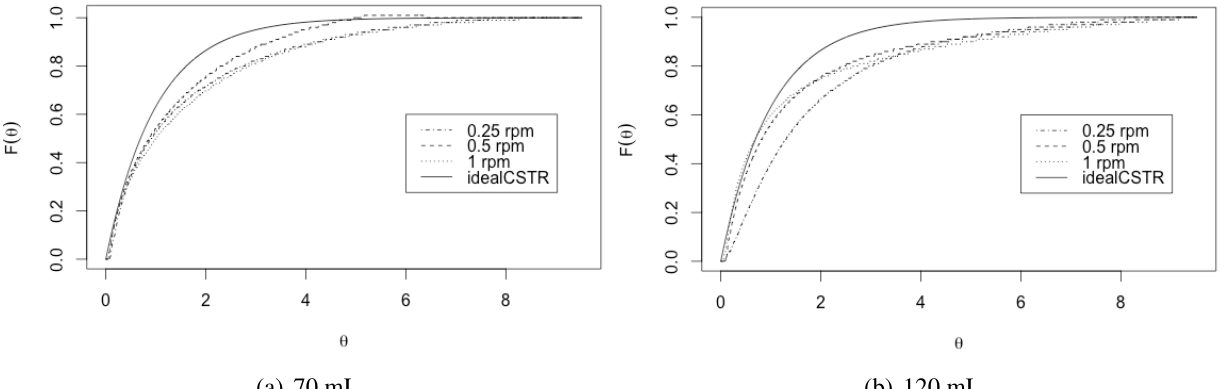
Figure 3. Accumulated residence time of Z ® RP 2000 H bioreactor for operation conditions of ( a ) 70 mL and ( b ) 120 mL volume depending on rotation speed of reactor bed (0.25, 0.5, 1 rpm), ( n = 1). Accumulated residence time for ideal continuous stirred tank reactor (CSTR) is plotted for comparison reasons.